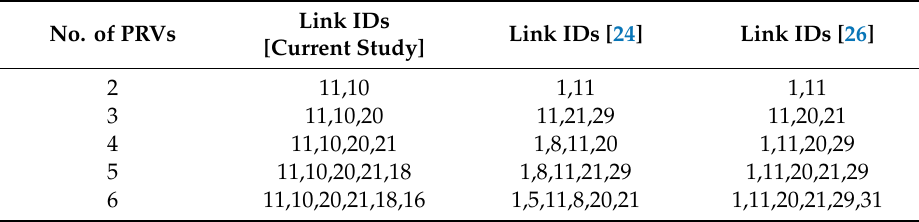
Table 4. Optimal PRV locations with 24 demand patterns.